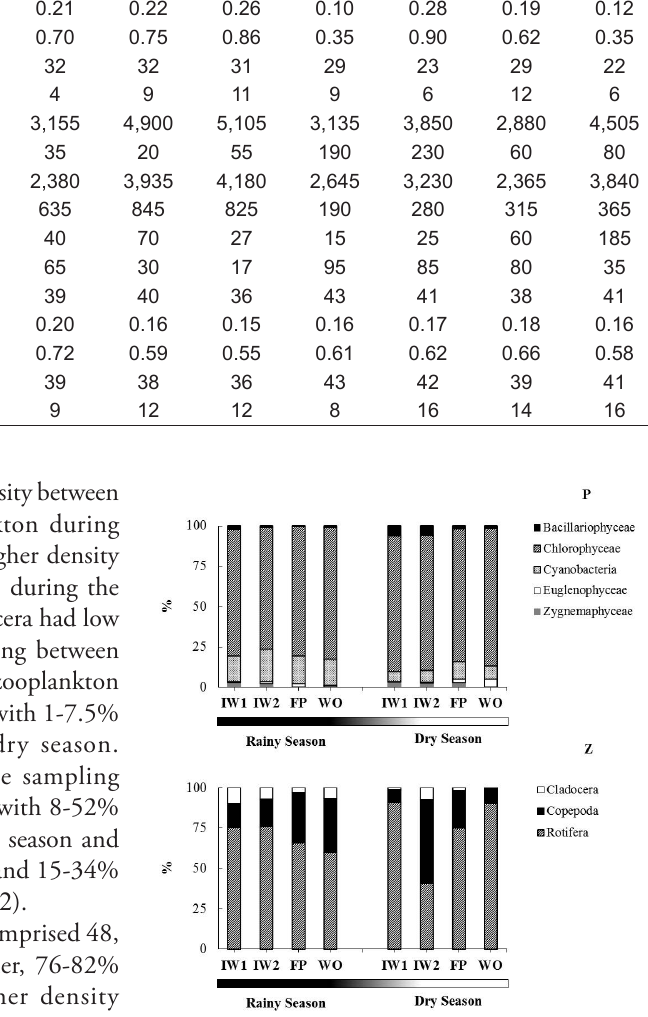
Figure 3. Relative abundance (%) of zooplankton (Z) and phytoplankton (P) identified recorded during the rainy and dry seasons (IW1 and IW2 = water inlets; FP = deep water site; WO = water